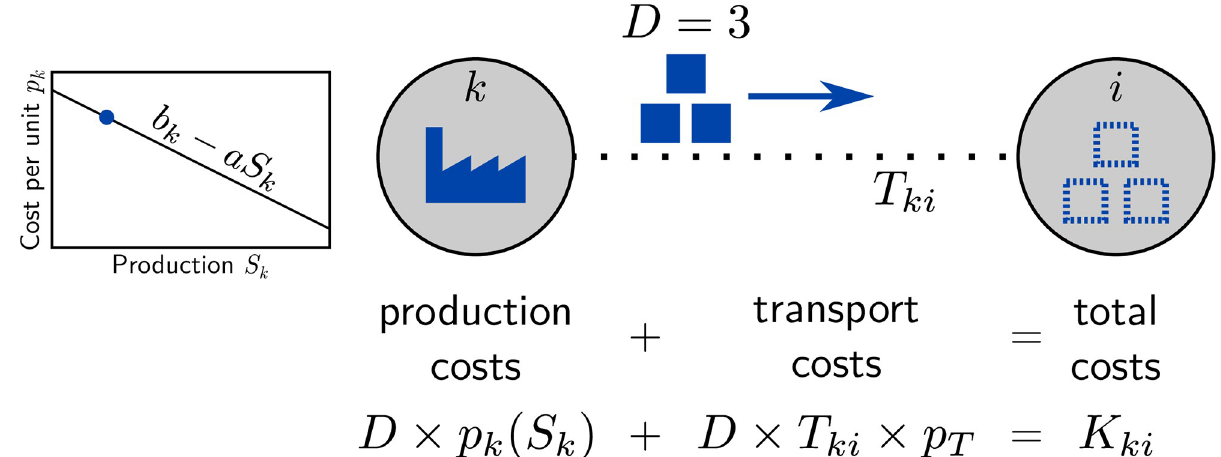
Fig 1. Network supply problem. Each node i chooses a supplier k to satisfy its demand D at minimal cost K production costs at node k , where the costs per unit depend on the total amount of production S k at that node (left panel), and (II) transport costs that depend on the distance T ki between the nodes k and i in the underlying transport network (dashed line). All nodes in the network (including k ) simultaneously solve their individual optimization problem.